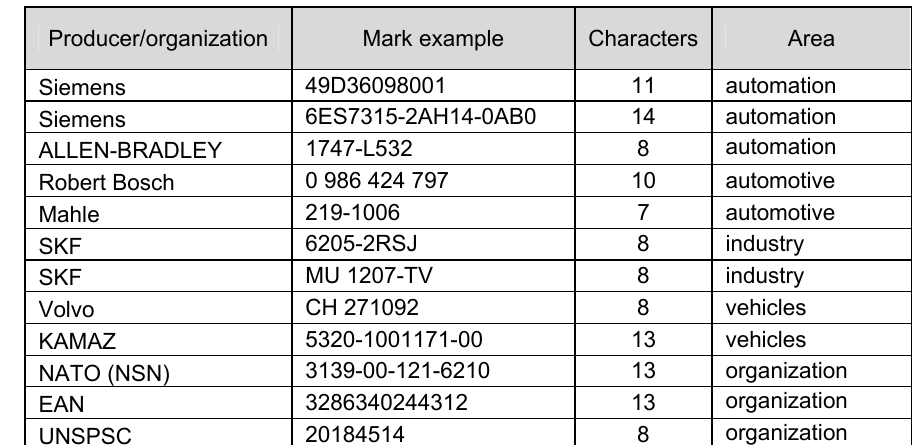
Table 1 – Example of product marking Таблица 1 – Практические примеры маркировки Табела 1 – Пимер означавања из